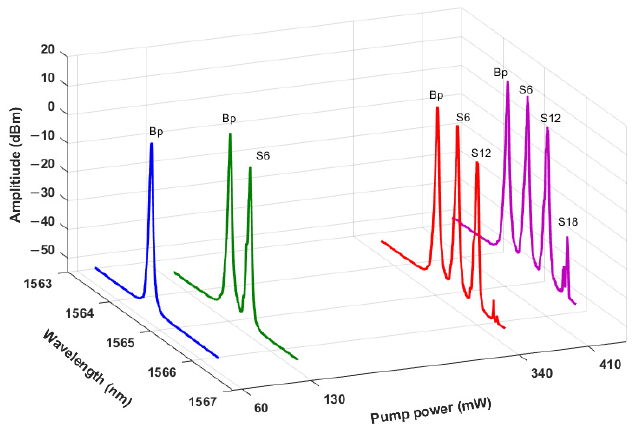
Figure 3. Threshold values of the sextuple Stokes signals.